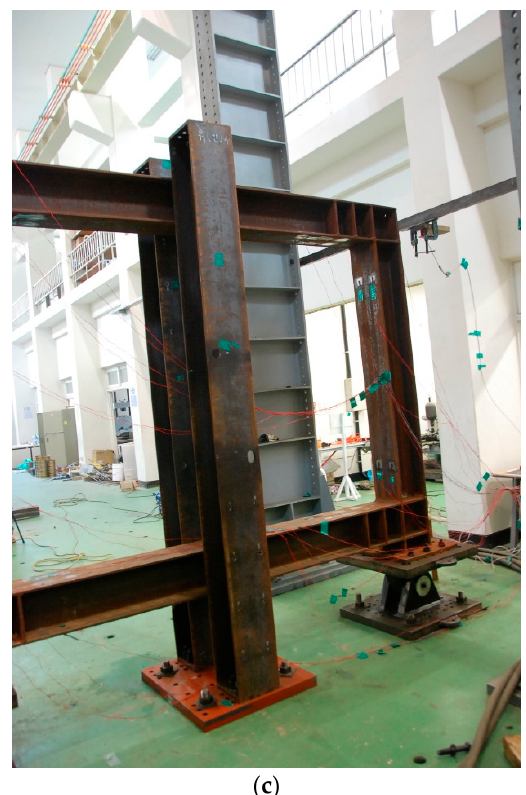
Figure 3. Experimental arrangement: ( a ) setup of specimens; ( b ) detail of the cyclic loading system; ( c ) two H-section steel beams.